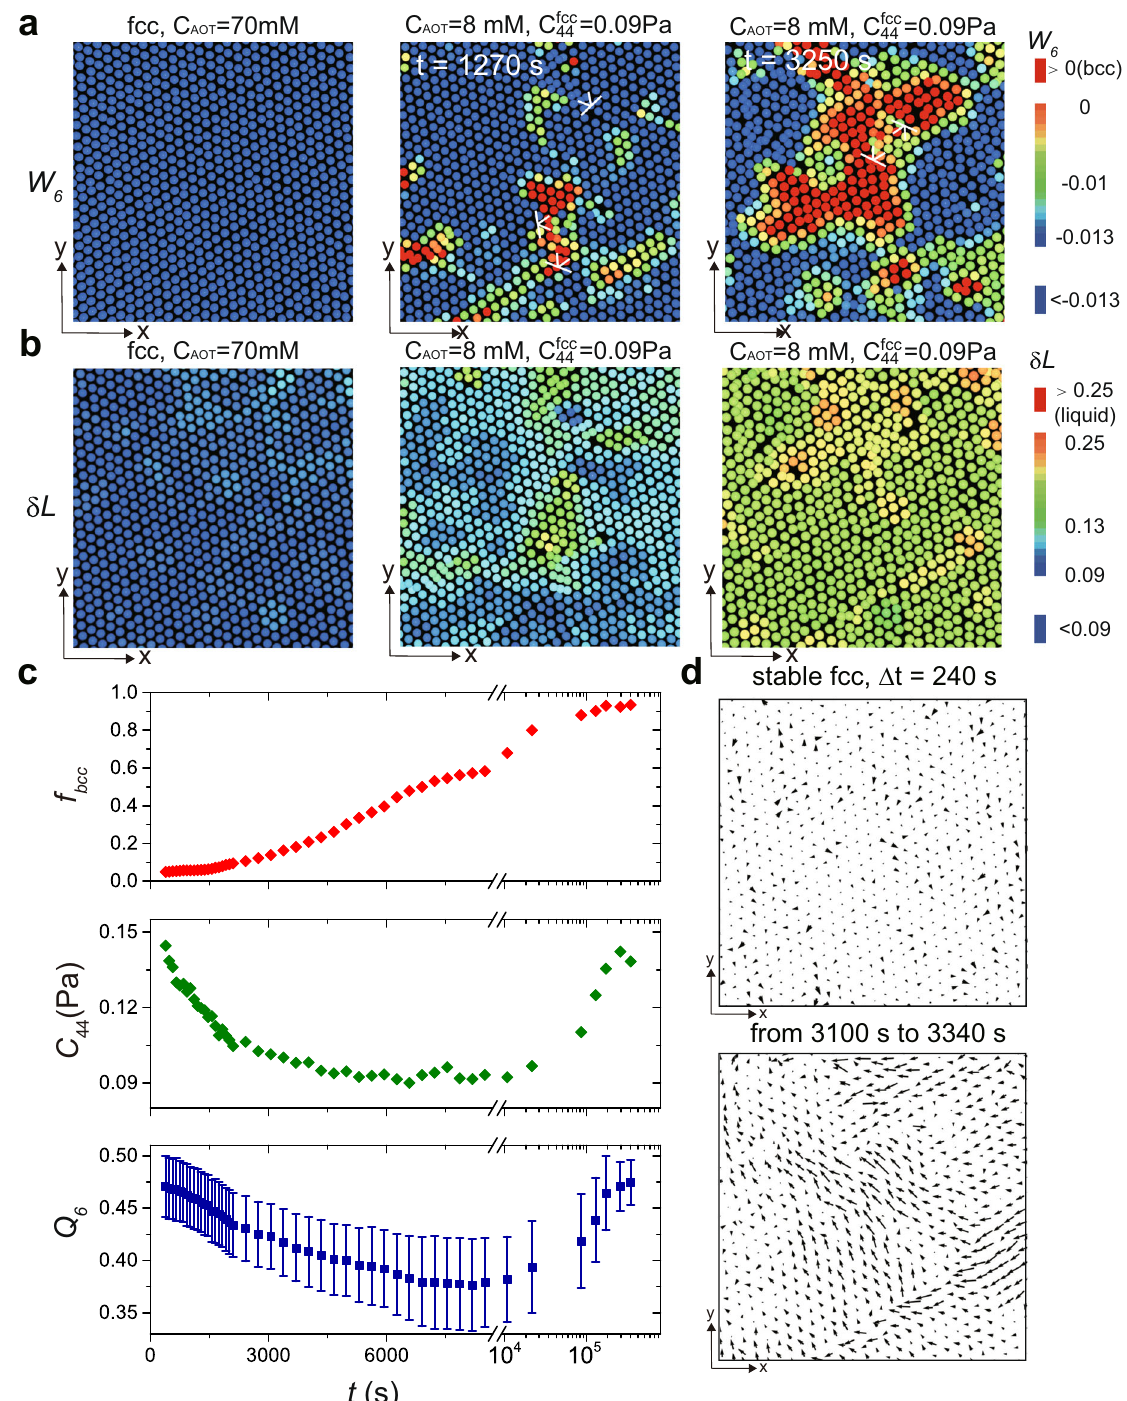
Fig. 6 The thermally activated inside-grain homogeneous nucleation for low-modulus, strong-driving-force transition. a Colour plot of W 6 of particles undergoing the fcc-to-bcc transition (red particles represent bcc; dislocations are speci fi ed). The bcc critical nucleus ( t ~3250 s, W 6 ≥ 0) appear in the region containing defects ( t ~1270 s), which spontaneously forms in the defect-free fcc lattice. b The colour plot of the Lindemann parameter δ L of particles undergoing the fcc-to-bcc transition, the regions with large Lindemann parameter ( t ~1270 s) well correspond to the regions of large W 6 fl uctuations (small bcc nuclei) in a . c Time evolution of the fraction of bcc solids, f bcc , the component C 44 of the shear modulus, and the average Q 6 of the system. The error bar of Q 6 represents the standard deviation. C 44 before the truncation point is calculated for the parent fcc lattice, whereas the one after the truncation point is calculated for the product bcc lattice. Q 6 is averaged over all particles in the system. In the nucleation stage ( t <3500 s), the formation of defects seen by the lowering of Q 6 coincides well with the drop of the shear modulus C 44 . In the late growth stage ( t >7.5×10 4 s), the slow eradication of defects seen by the growth of Q 6 also coincides well with the increase of C 44 . d The displacement fi eld of particles (at Δ t ~240 s) of the initial fcc lattice (see the top panel, t <0) and that of particles after the formation of a critical bcc nucleus ( t ~3250 s, bottom panel). Due to the small shear modulus C fcc , the bcc nuclei are created by displacive 44 heterogeneities corresponding to the slipping motion of particles. The particles shown in panel d are the same as those in ( a and b